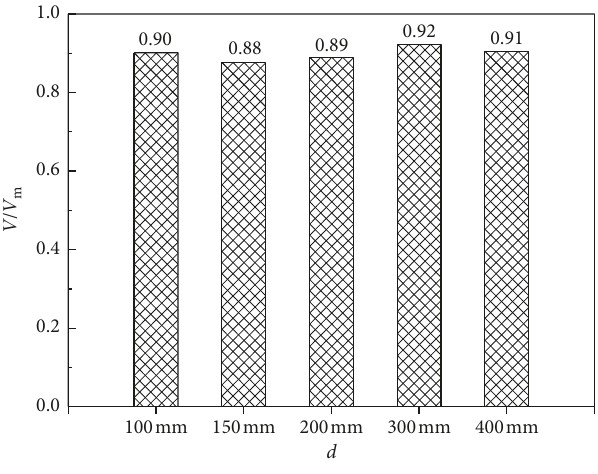
Figure 29: The lateral strength ratios. Figure 28: Calculation diagram of the lateral